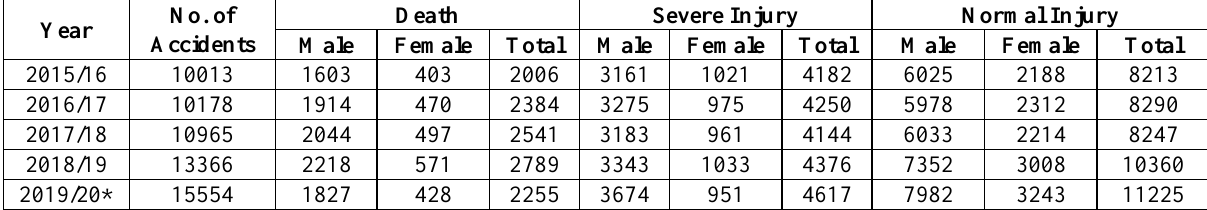
Table 22: Road Crashes and Injuries